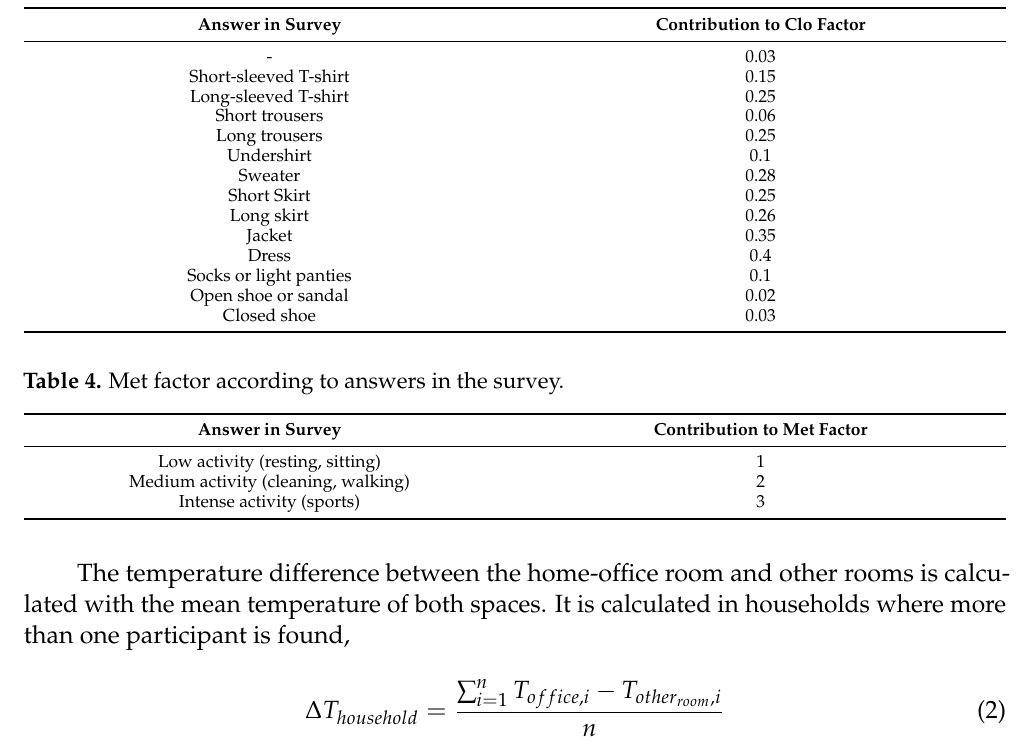
Table 3. Contribution to clo factor related to answers in the survey.